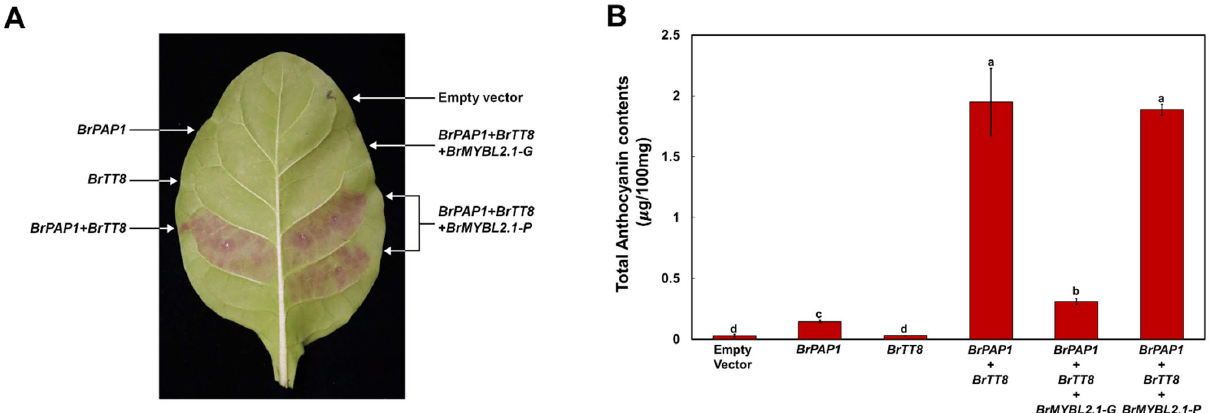
Figure 6. Functional analysis of BrMYBL2.1 ‐ G and BrMYBL2.1 ‐ P for anthocyanin biosynthesis, as a repressor. Visual phenotype and anthocyanin contents in tobacco leaves transiently infiltrated with Agrobacterium strains harboring an empty vector or constructs BrPAP1 , BrTT8 , BrMYBL2.1 ‐ G , and BrMYBL2.1 ‐ P in the indicated combinations. ( A ) Representative photograph of a transiently infiltrated tobacco leaf 5 days after agroinfiltration. ( B ) Anthocyanin contents of the leaf sections shown in (A). Results are the means ± SD from three independent biological replicates. Different letters indicate significantly different values ( p < 0.01), as determined by one ‐ way ANOVA followed by Duncan’s multiple range tests.